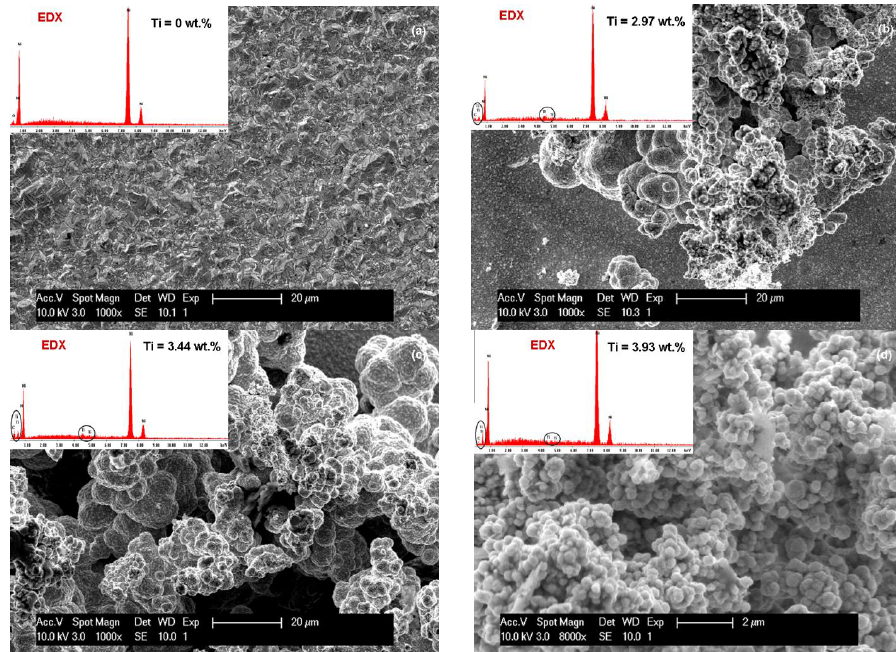
Figure 6. SEM surface morphology and EDX compozition for electrodeposited layers: ( a ) Ni/nano-TiC (0 g · L −1 ); ( b ) Ni/nano-TiC (10 g · L −1 ); ( c ) Ni/nano-TiC (15 g · L −1 ); and ( d ) Ni/nano-TiC (20 g · L −1 ) obtained at current density of 72 mA/cm 2 and deposition time of 30 min. The labelled element in EDX spectrum is titanium (Ti), which confirm the inclusion of TiC particles.